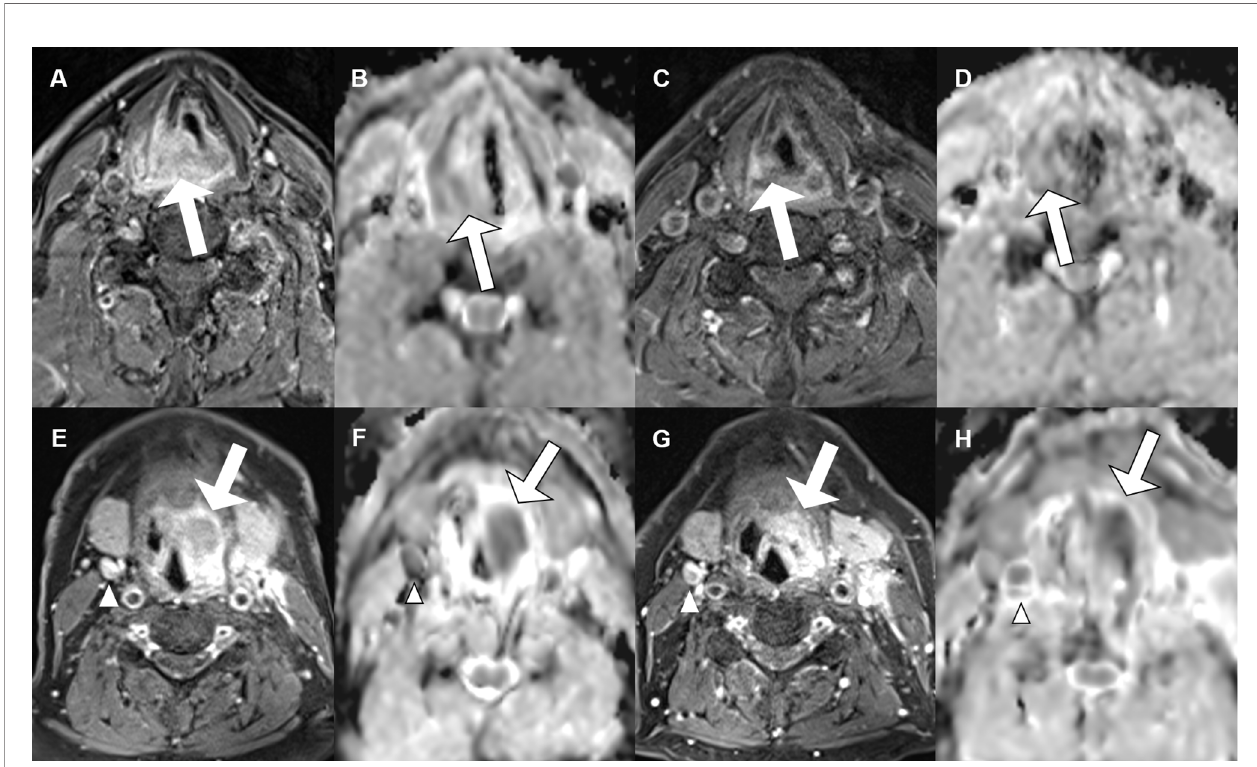
FIGURE 4 | Morphological and functional MRI images for two patients with pharyngeal carcinoma (primary tumor is marked with an arrow, lymph node metastasis with an arrow head), contrast enhanced T1 weighted GRASP-VIBE sequence (A, C, E, G) and ADC map (B, D, F, H) for both a patient with pathologic complete response (upper row) and a patient with residual tumor (lower row) at baseline [ (A, B) and respectively (E, F) ] and at follow-up [ (C, D) and respectively (G, H)